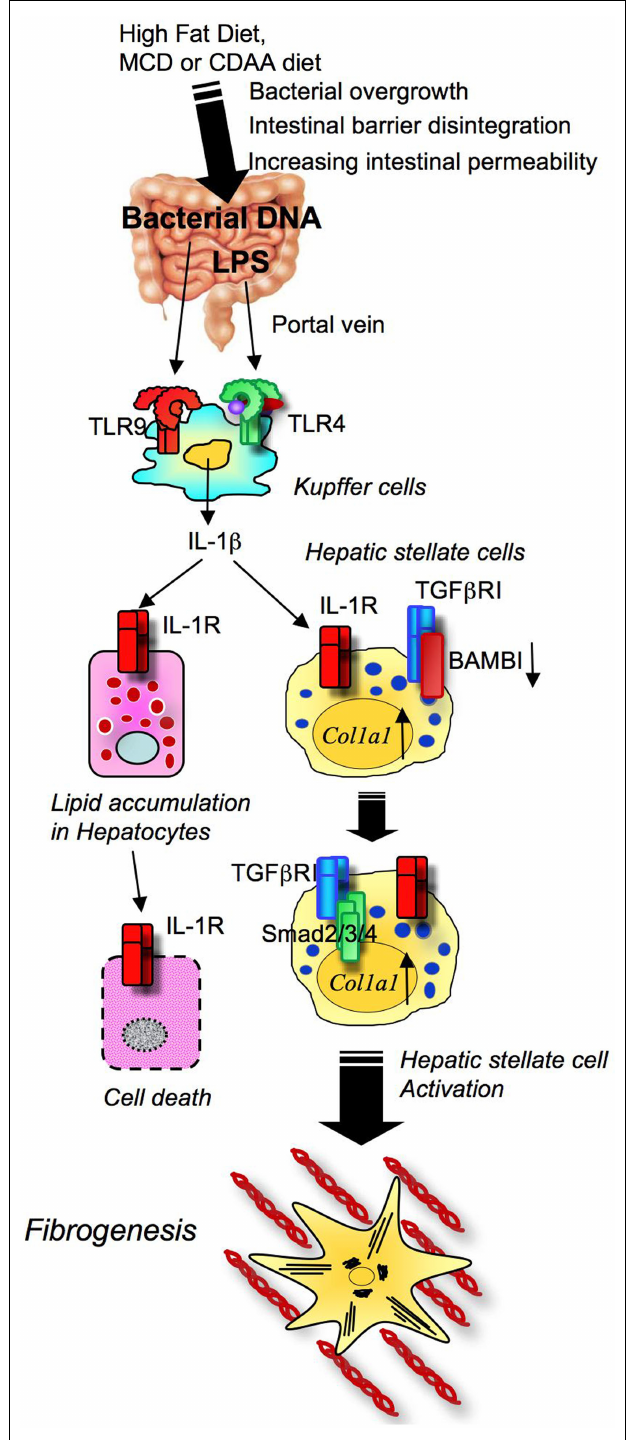
FIGURE 6 |Toll-like receptor signaling and NASH development. High fat diet feeding and obesity conditions affect the composition of intestinal microflora and bacterial overgrowth. In NASH, translocated LPS and CpG-DNA stimulatesTLR4 andTLR9 on Kupffer cells to produce IL-1 β , which induces hepatocyte steatosis and death, and ultimately activates HSC, resulting in